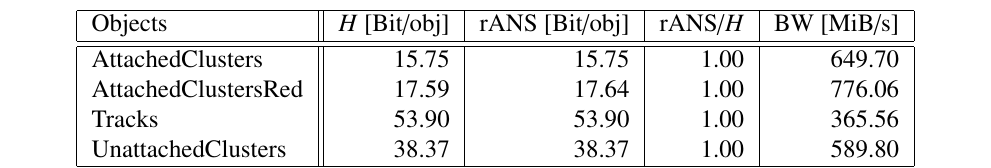
Table 2: Performance of rANS entropy coding for the ALICE TPC sample data.